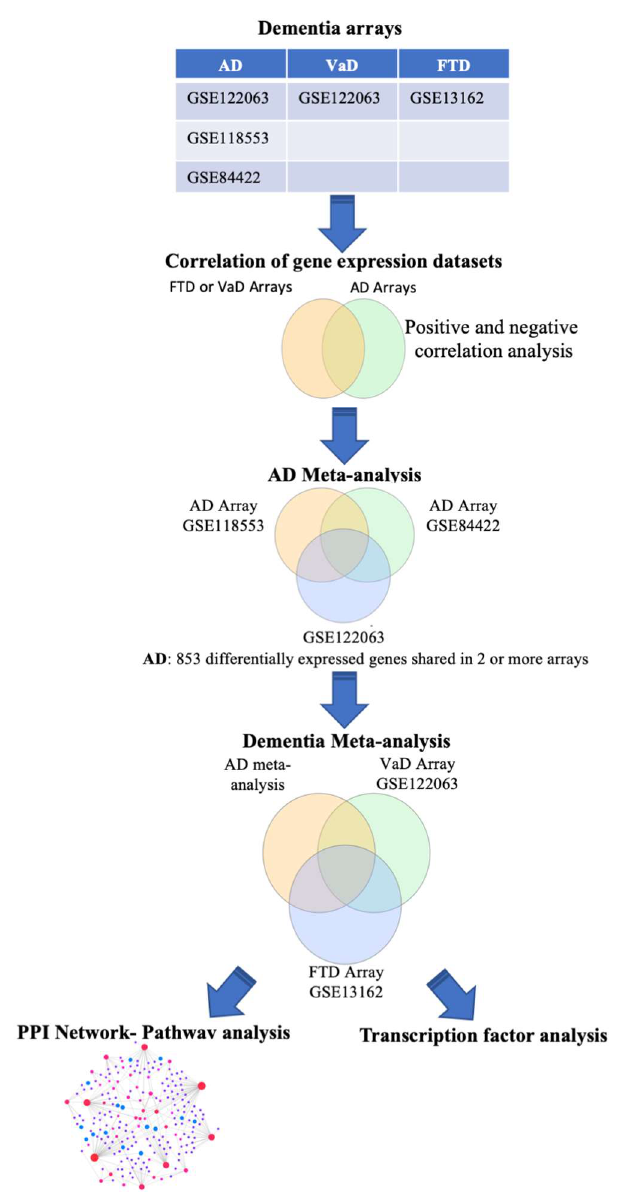
Figure 1. Flowchart of the study. Microarray data from postmortem brain tissue of Alzheimer’s disease (AD), vascular dementia (VaD), and frontotemporal dementia (FTD), patients was curated and differential gene expression analyzed using the BaseSpace Correlation Engine (BSCE). Meta-analysis of 3 independent AD studies was performed using BSCE. The list of genes identified in the AD meta-analysis was compared to the differentially expressed genes in VaD and FTD using a Venn diagram analysis. Protein–protein interactions and transcription factors (TF) network analysis identified dysregulated pathways and TF shared and unique to each dementia.